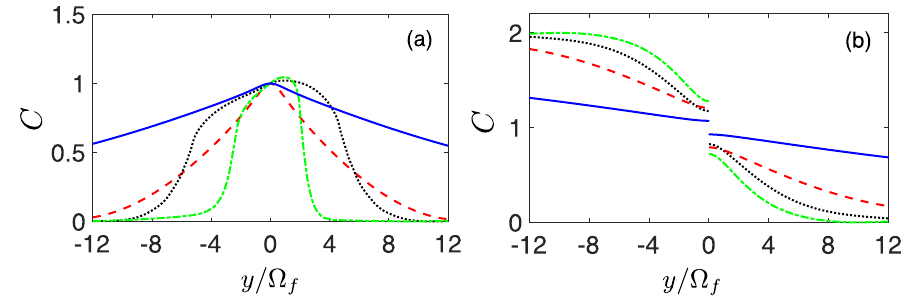
3 i ( a ) and FAQUAD ( b ) for 0 a i t i = 0.5 (dotted-black), and t = f = (cid:31)